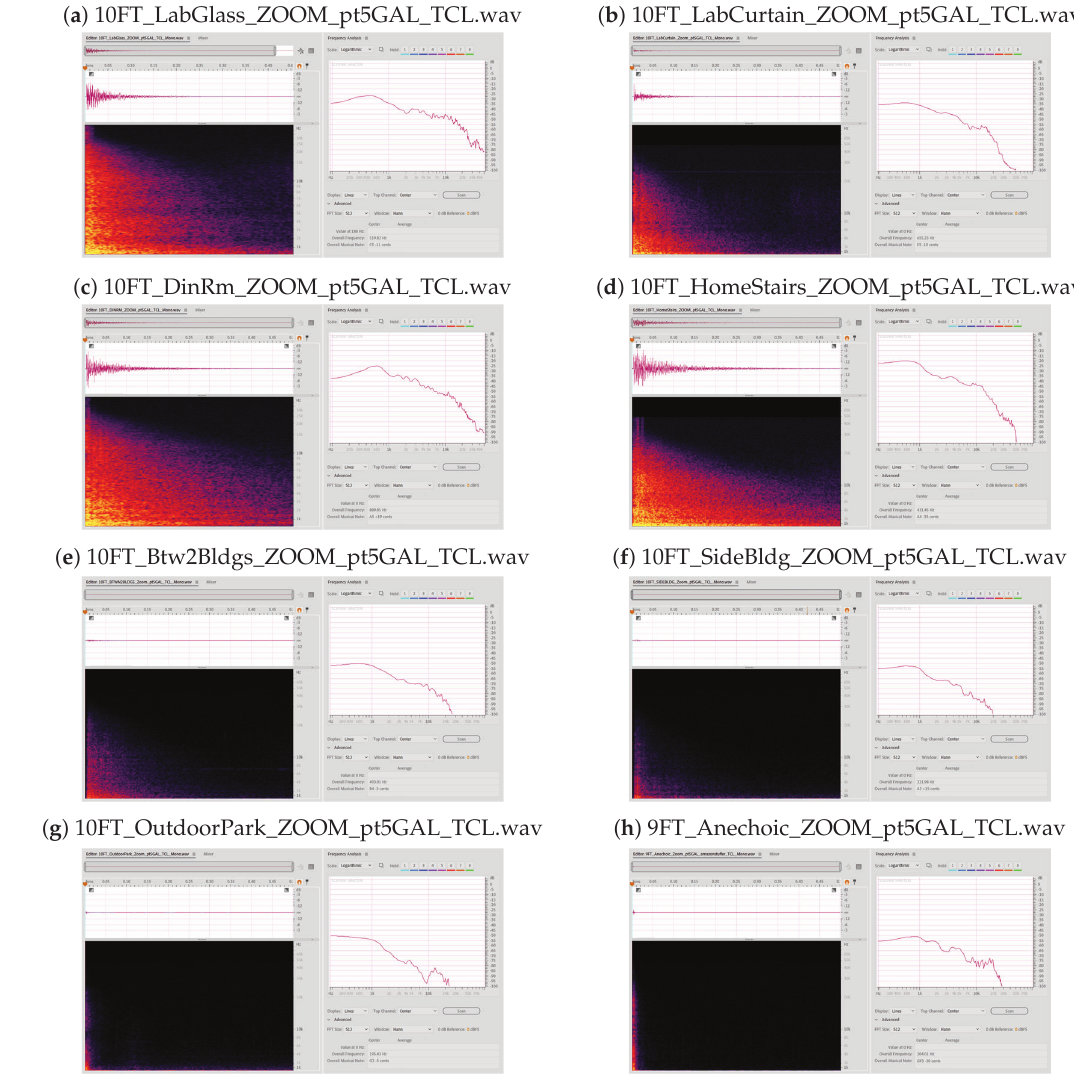
Spectrogram plots for the different environment of the Zoom microphone.